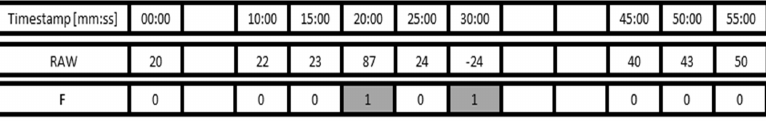
Figure 2. Raw data with faulty and missing data.